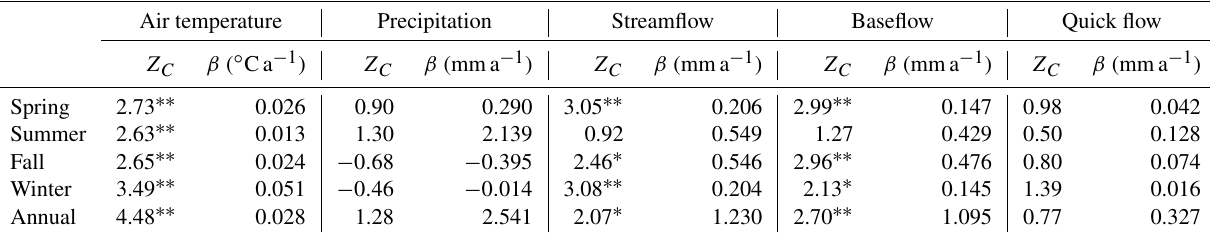
Table 1. Mann–Kendall trend test with trend-free pre-whitening of seasonal and annual mean air temperature ( ◦ C), precipitation (mm), streamflow (mm), baseflow (mm) and quick flow (mm) from 1979 to 2013. Air temperature Precipitation Streamflow Baseflow Quick